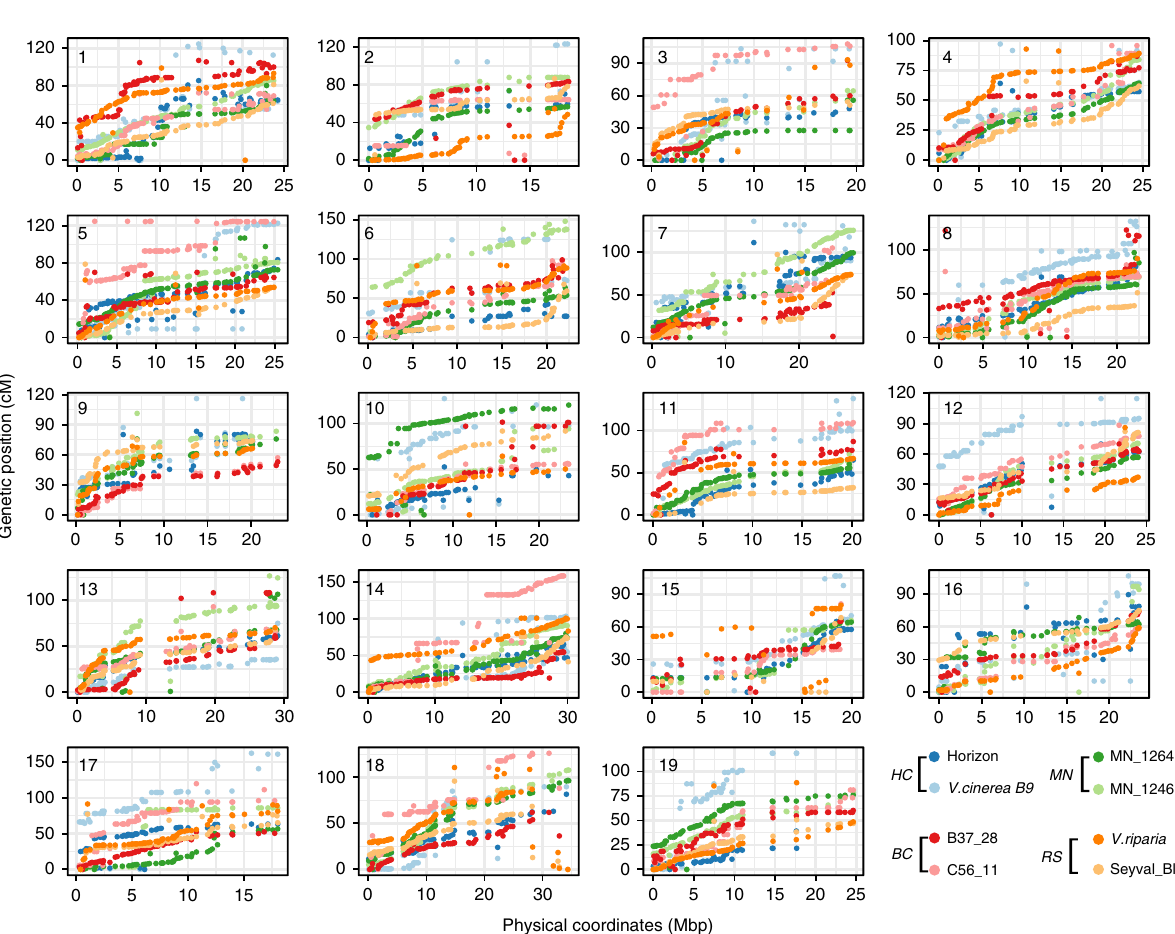
Fig. 4 Relationship between the genetic and physical maps for the nineteen chromosomes of the parents in four families. Genetic distance: cM; Physical maps: Mbp. The genetic distances of the markers were derived from the genetic map developed for each family and physical distances are from version 12X.2 of the PN40024 reference genome.